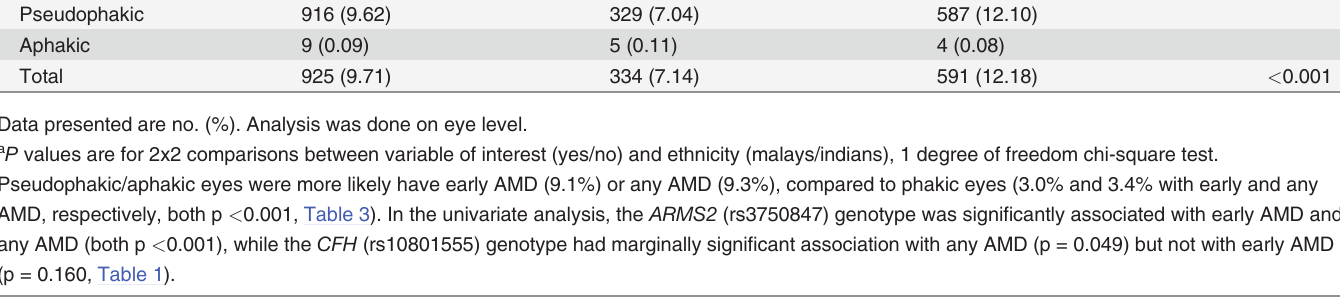
Stratified analysis was performed for the phakic vs. pseudophakic/aphakic groups ( Table 5), adjusted for age, gender and the first 5 genetic principal components. In phakic eyes, the risk of early AMD was similar in those with the CFH Y402H risk genotypes (genotype GA: OR = 0.95, 95% CI: 0.73 – 1.25; AA: OR = 0.91, 95% CI: 0.53 – 1.55), to those with GG genotype. In contrast, pseudophakic/aphakic eyes that had the Y402H risk genotype were more likely to have early